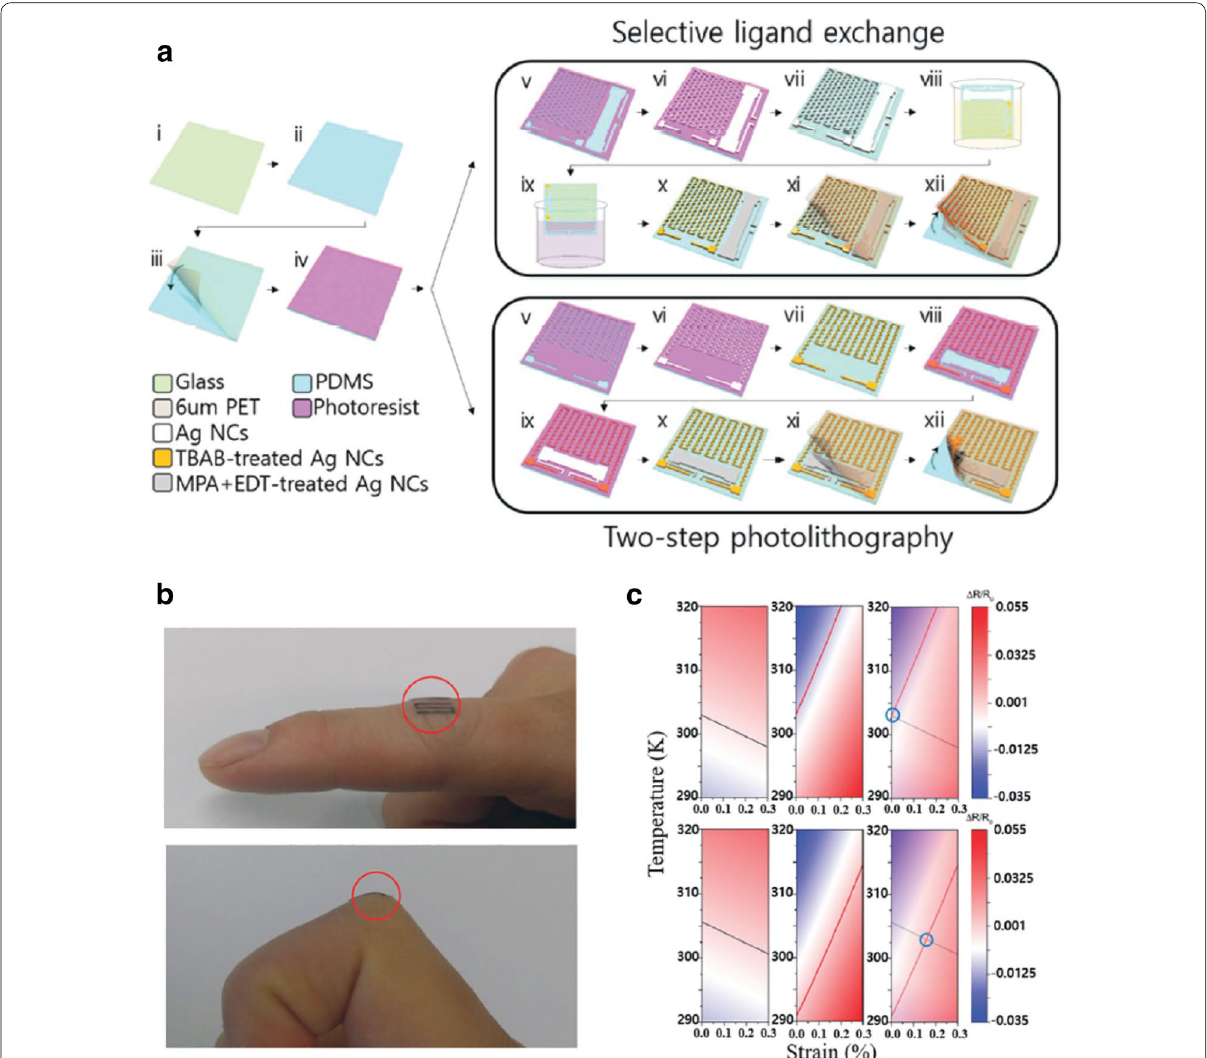
Fig. 7 a Schematic of fabrication process for the strain–temperature sensors. b Images of the sensor on human finger (top) in a flat state and (bottom) in a bent state. c Simulation and experimental results of the sensors (top) in a flat state and (bottom) bent state (Figure reproduced